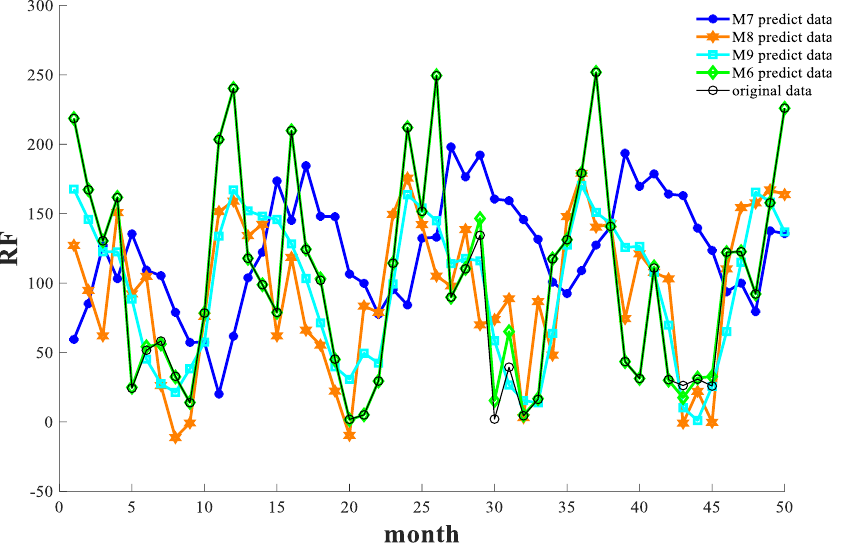
Figure 20. Predicting effect of the observed and predicted lowest temperature (unit: °C) using M6 − M9 models.